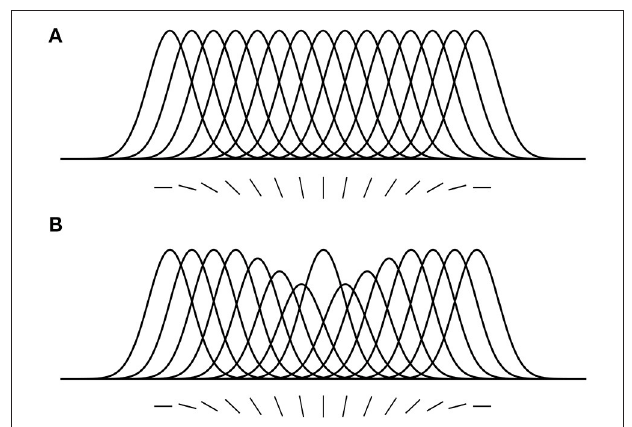
FIGURE 2 | Feature-based attentional surround suppression in the orientation map. (A) Hypothetical tuning curves for different orientations. (B) Attention to the vertical orientation inhibits neighboring orientations and changes the overall tuning profile in the orientation map (adapted from Tsotsos, 2011 with